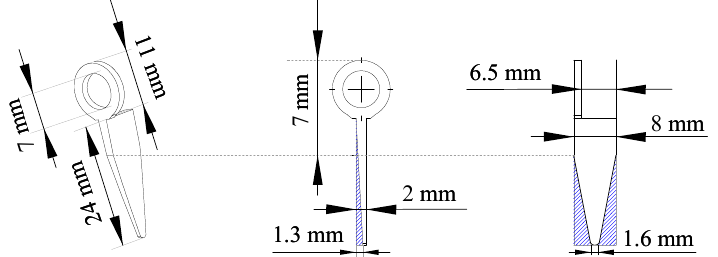
Figure 10. Drawing of picking slices structure. The blue section line in the figure is the excised part.